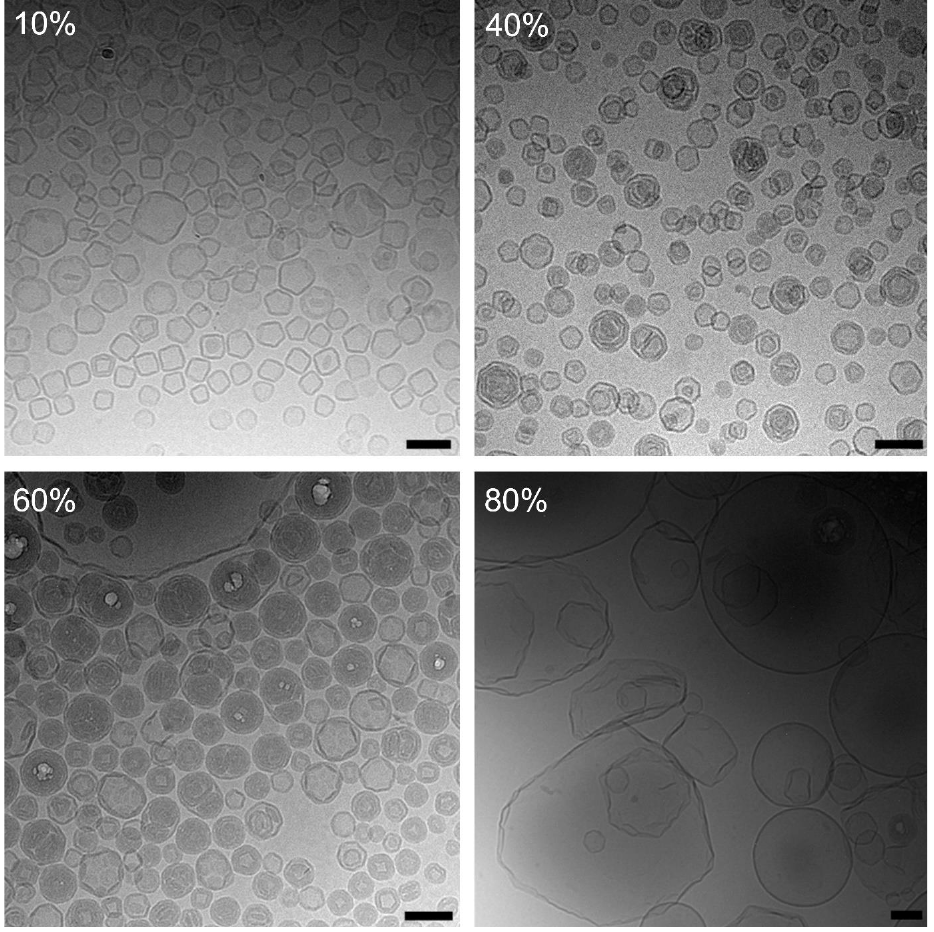
Figure 7. Cryo-EM images of DPPC-liposomes prepared by DC at 10%, 40%, 60%, and 80% lipid concentrations (VPG) at 2350 rpm, at 20 °C, and for 30 min with TRIS buffer and redispersed with concentrations (VPG) at 2350 rpm, at 20 ◦ C, and for 30 min with TRIS buffer and redispersed with the same buffer by DC at 1500 rpm, at 20 °C, and for 2 min. In-vial temperature after preparation was about 40 °C. Scale bar: 100 nm.